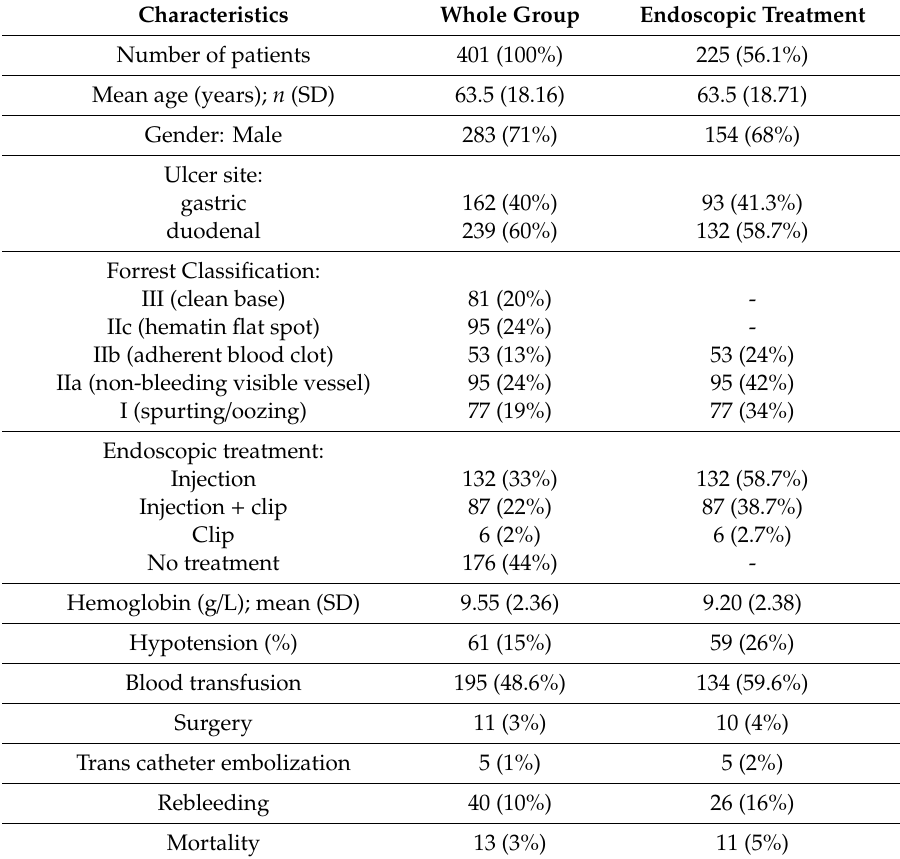
Table 1. Demographic data and clinical characteristics in the study